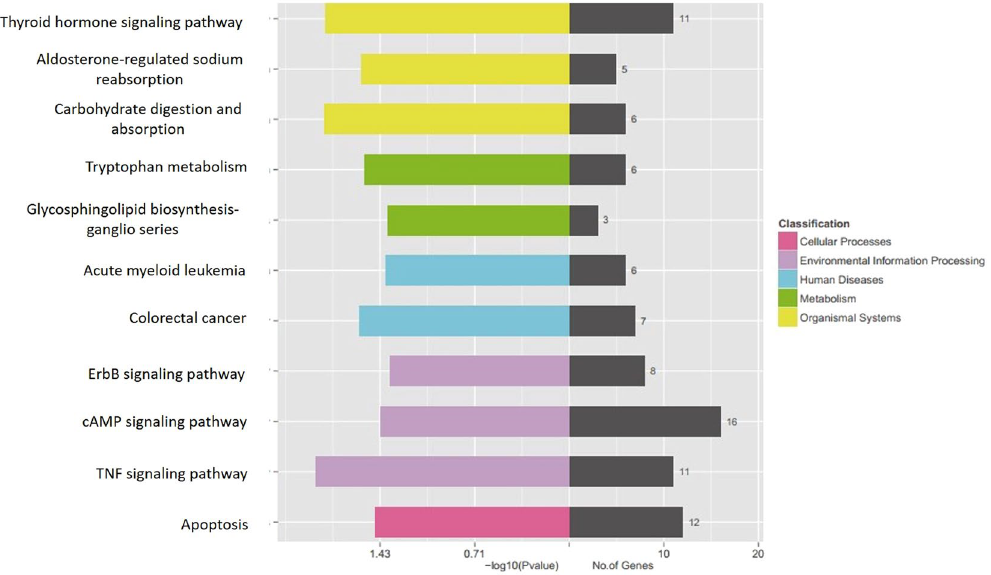
Figure 8. KEGG pathway analysis of target genes of DE lncRNAs. The KEGG pathway enrichment analysis was performed on the KEGG biological pathways database (http://www.genome.jp) 44–46 . The left side of the coordinate axis shows the P-values of the pathway, and the yellow, green, blue, purple, and pink colors indicate the KEGG classification: organismal systems, metabolism, human diseases, environmental information processing, and cellular processes. On the right side of the coordinate axis, the gray color represents the number of genes enriched in the